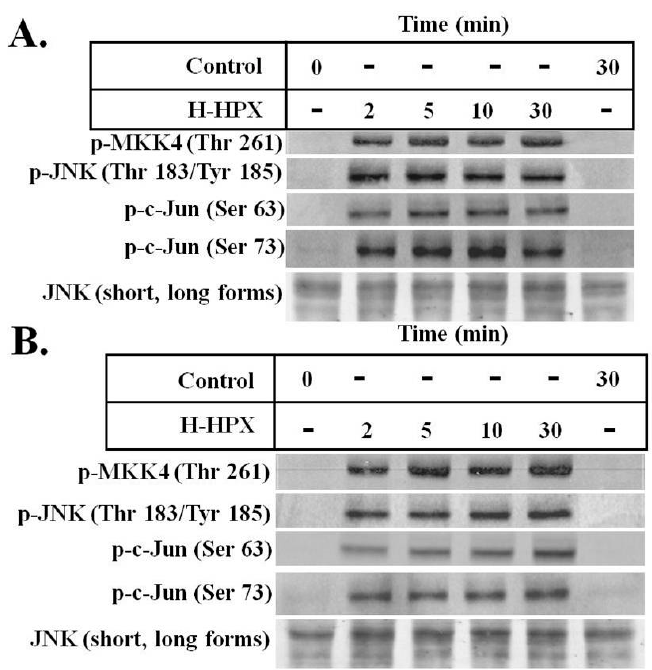
Figure 1. Heme-hemopexin activates the JNK pathway via MKK4 in hepatic and neuronal cells. In panel ( A ) Mouse Hepa cells were incubated with PBS (control) or heme-HPX (5 µ M, H-HPX in PBS) for up to 30 min as indicated. The levels of p-MKK4 and p-JNK—both kinases of the JNK pathway and of p-c-Jun, a substrate of JNK, together with total JNK levels—were detected by immunoblotting of cell extracts (40 µ g protein / lane), as described briefly below. ( B ) Data shown are from a similar time course experiment to determine the e ff ects of heme-HPX on the JNK pathway and c-Jun phosphorylation in rat PC12 cells. The data shown in both panels are from a representative experiment of two independent biological replicates. Hepa cells are minimal deviation hepatoma cells from a mouse solid tumor line BW 7756 and were grown and maintained as previously described [1]. Western blots were performed by loading the same amount of protein from the sample of cell lysate per lane (40 µ g protein / lane), and after electrophoresis on SDS-PAGE gels, the proteins were transferred to a nitrocellulose membrane (Bio-Rad, Hercules, CA, USA). Primary antibodies (Thermo-Fisher Scientific, Waltham, MA, USA) used at 1:1000 dilution, were detected by binding a secondary antibody of goat anti-rabbit IgG horseradish peroxidase (generally 1:5–10,000) and the peroxidase enzyme activity detected using the chemiluminescence ECL system (Amersham Pharmacia Biotech, Piscataway, NJ, USA). Data were collected using a multifunction phosphoimager / fluorimager laser scanner (Molecular Dynamic Storm Molecular Imager, LICOR, Lincoln, NE, USA).